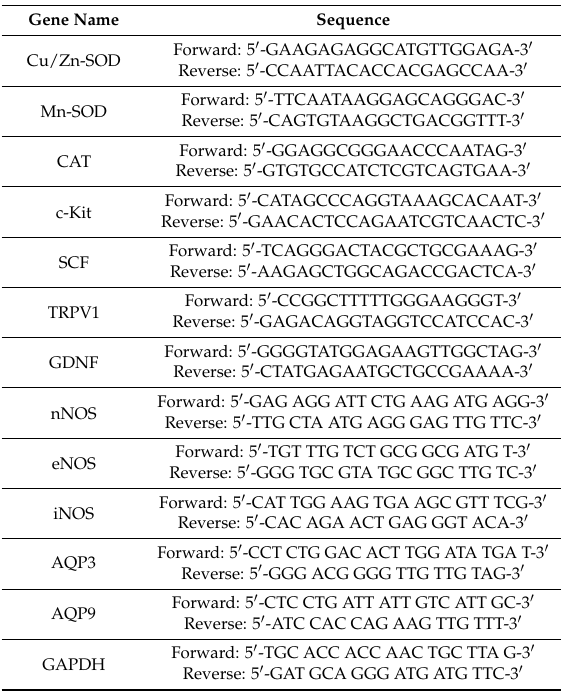
Table 1. Sequences of primers used in this